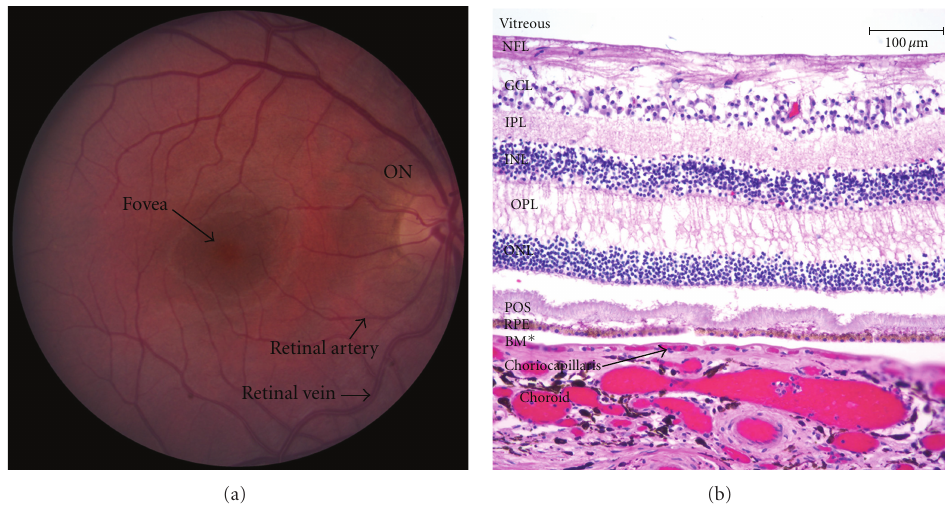
Figure 1: (a) Fundus photo of the right eye. The macula is located between vascular arcades with the fovea at the center approximately 3mm temporal to the optic nerve (ON). (b) Histopathological section of the neurosensory retina from the inner (vitreous) to outer layers: nerve fiber layer (NFL), ganglion cell layer (GCL), inner plexiform layer, inner nuclear layer (INL), outer plexiform layer (OPL), outer nuclear layer (ONL), outer segments of the photoreceptors (POS), underlying retinal pigment epithelium (RPE), Bruch’s membrane (BM ∗ ), and choriocapillaris and choroid